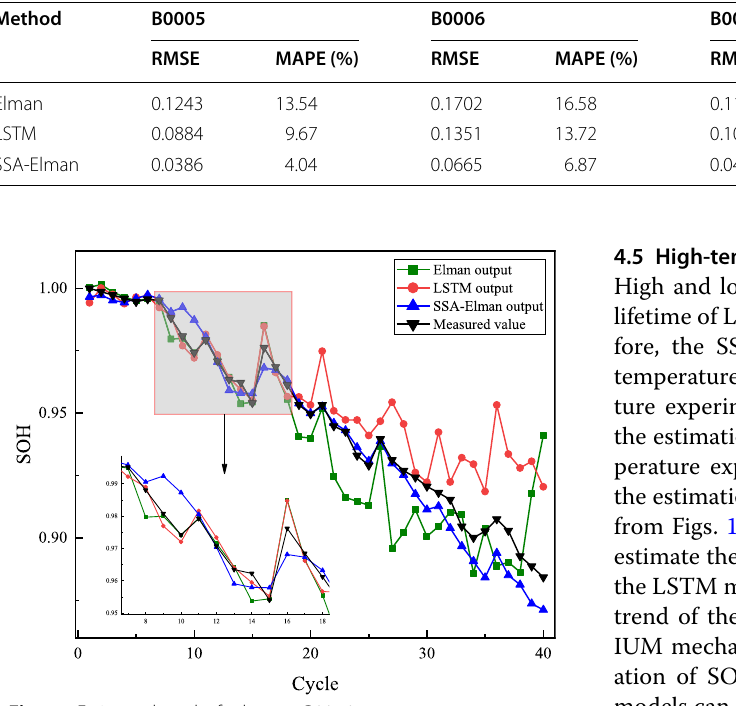
Fig. 15 Estimated results for battery B0046